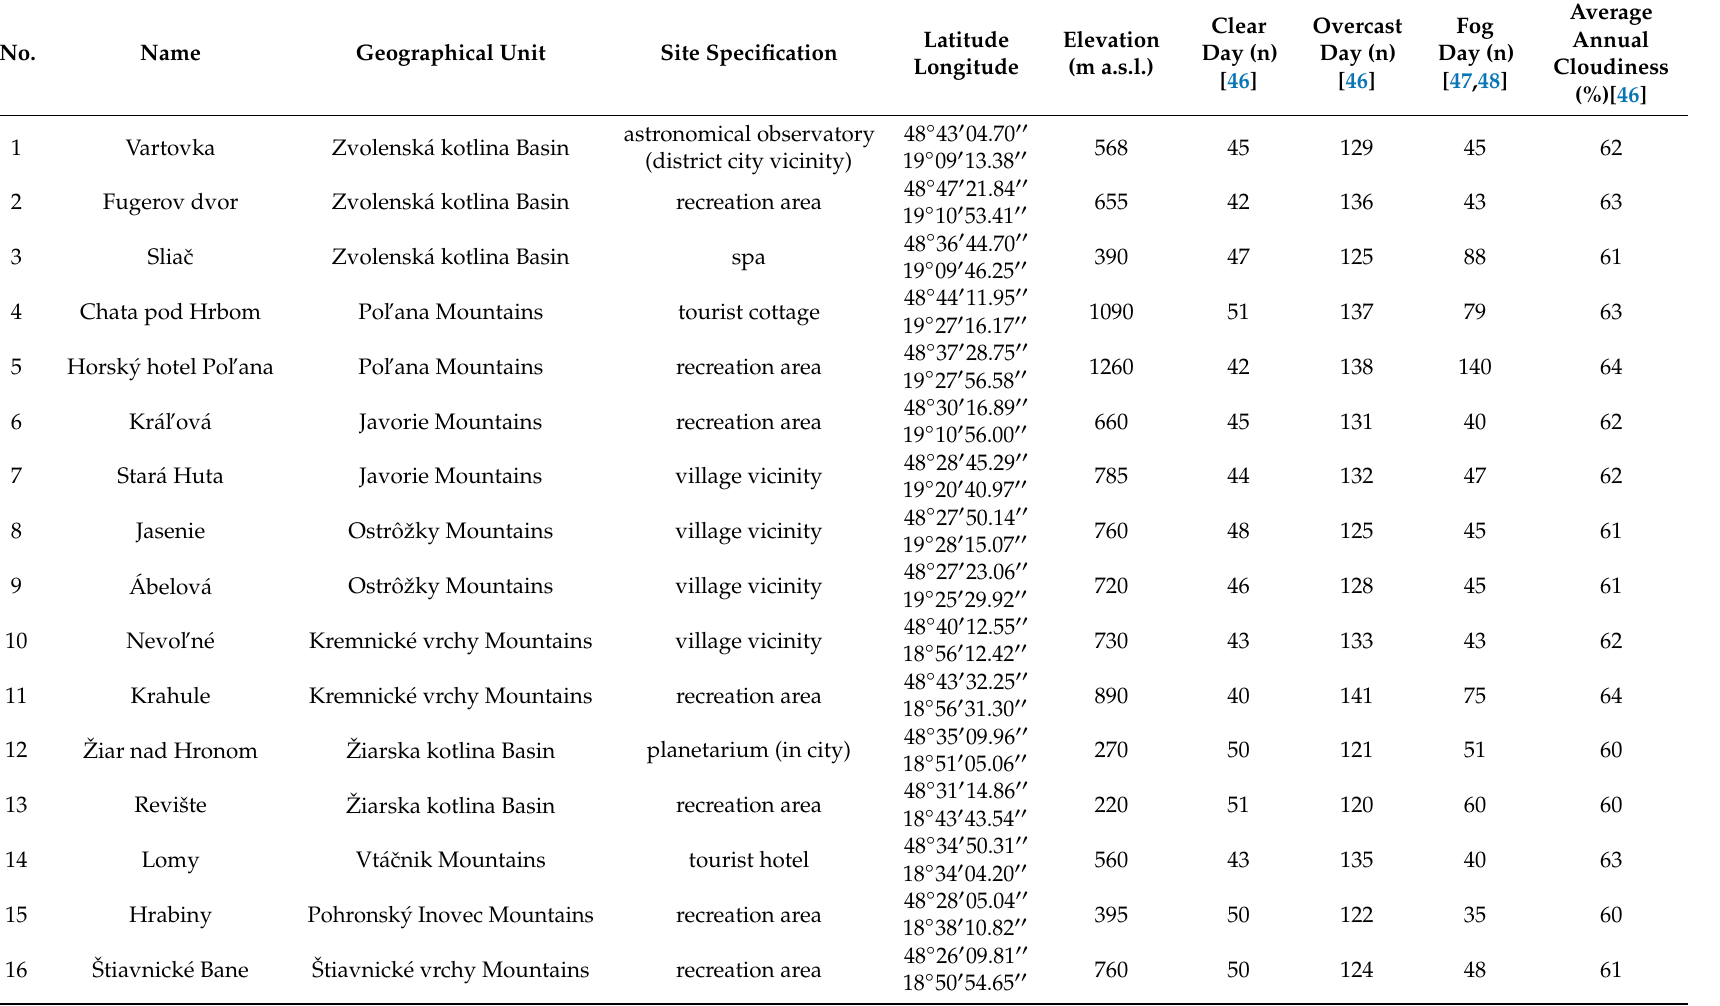
Table 1. Site geographical and climatological